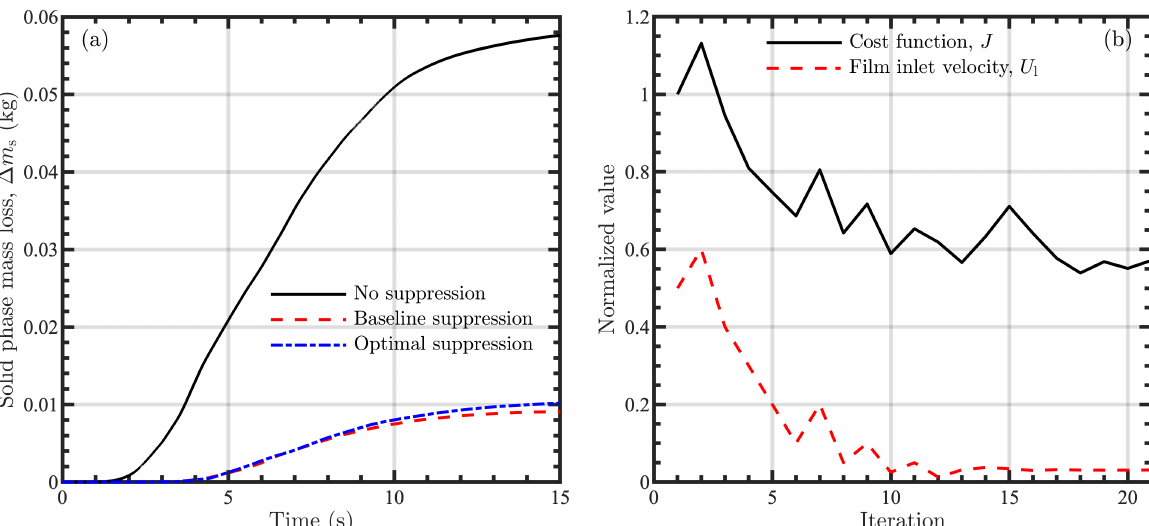
Figure 9. Solid-phase mass loss comparison for panel fire spread cases with and without water film suppression ( a ) and convergence history for the optimization ( b ). Panel ( a ) shows the mass loss for cases with no suppression (solid black line), baseline suppression parameters (dashed red line), and optimal suppression parameters (dash-dot blue line). Panel ( b ) shows normalized values of the cost function J from Equation (13) (solid black line) and the film inlet velocity U l (dashed red